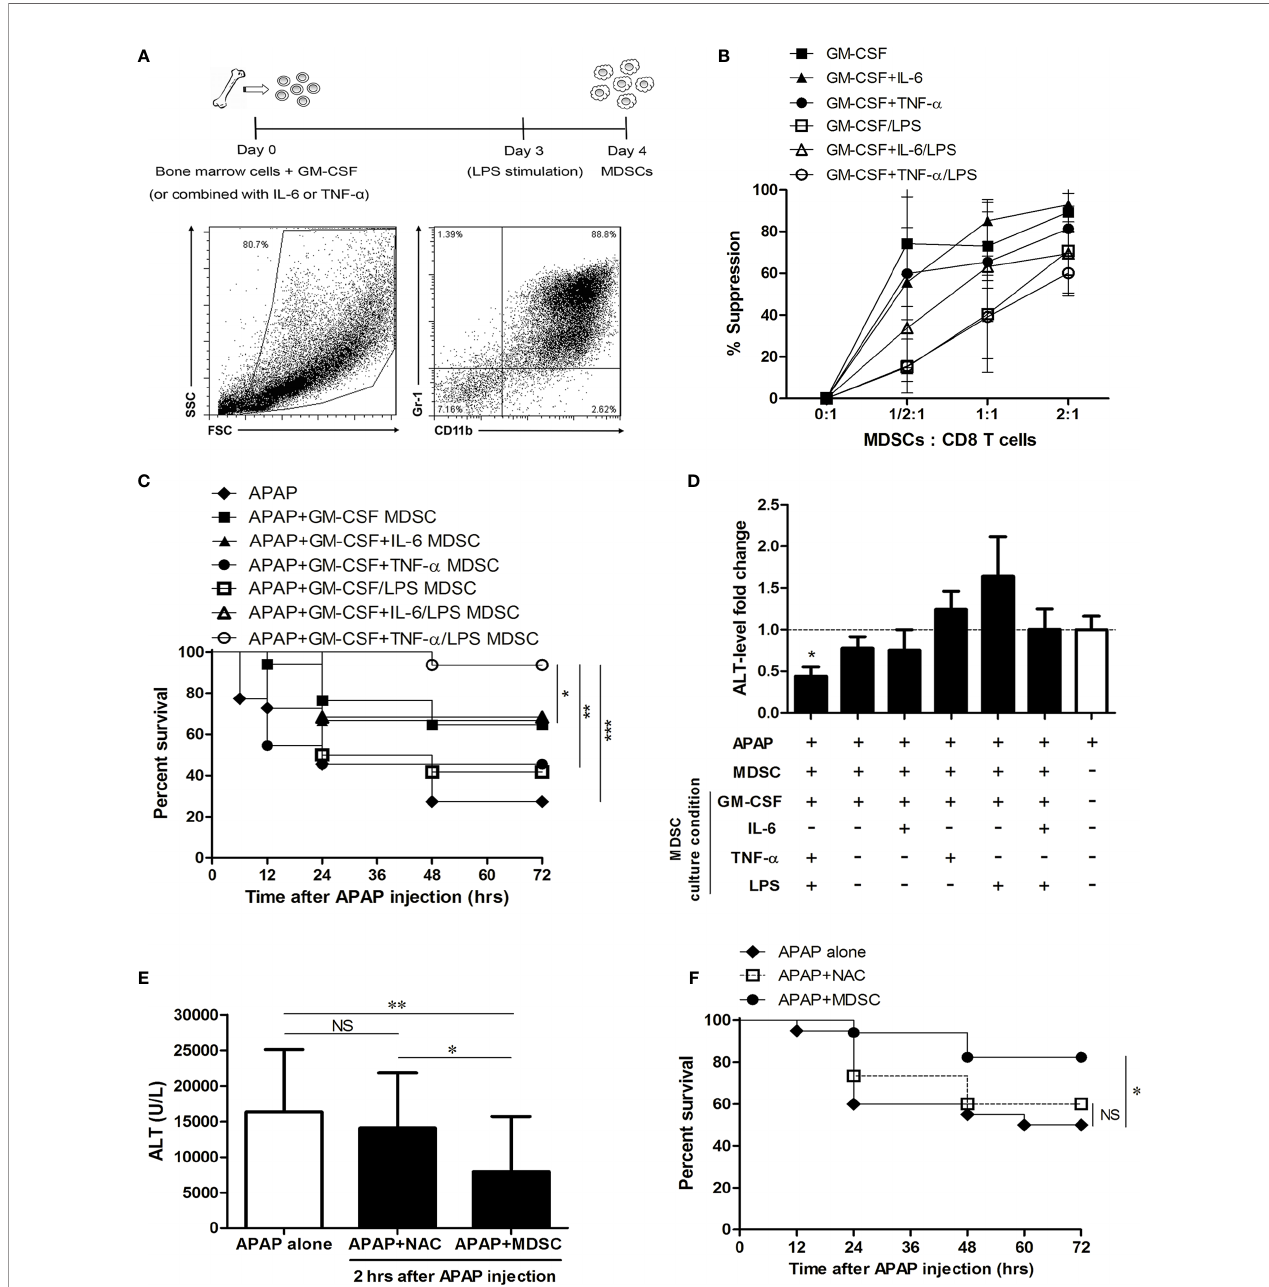
FIGURE 4 | The therapeutic effect of in vitro -generated myeloid-derived suppressor cells (MDSCs) in APAP-induced liver injury. (A) The experiment scheme of in vitro -generated MDSCs. (B) The suppressive abilities of MDSCs. These in vitro -generated MDSCs (8 x 10 6 cells) were adoptively transferred into mice just after APAP challenge to evaluate the survival (C) and the fold change of ALT level at 12 h after APAP injection (D) , n=12-16 per group. Log-rank test and Kruskal-Wallis test are used to analyze survival curve and the fold change of ALT level respectively. *P < 0.05, **P < 0.01, ***P < 0.001. (E) The ALT level of the post-treatment of TNF- a /LPS MDSC or NAC at 12 h after APAP injection. At 2 h after APAP injection, TNF- a /LPS MDSCs were adoptively transferred into mice, and NAC was intraperitoneally injected into mice respectively, n=15-20 per group. *P < 0.05, **P < 0.01, NS, no signi fi cance, Kruskal-Wallis test. (F) The survival of the post- treatment of TNF- a /LPS MDSC and NAC (n=15-20 per group). *P < 0.05, **P < 0.01, ***P < 0.001, NS, no signi fi cance, Log-rank test. Data were expressed as mean ±